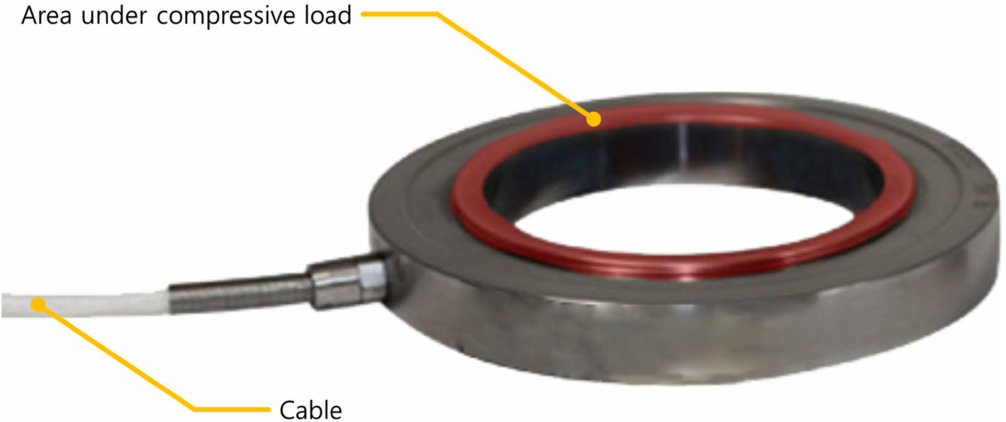
Figure 4. Commercial compression-type load-cells.